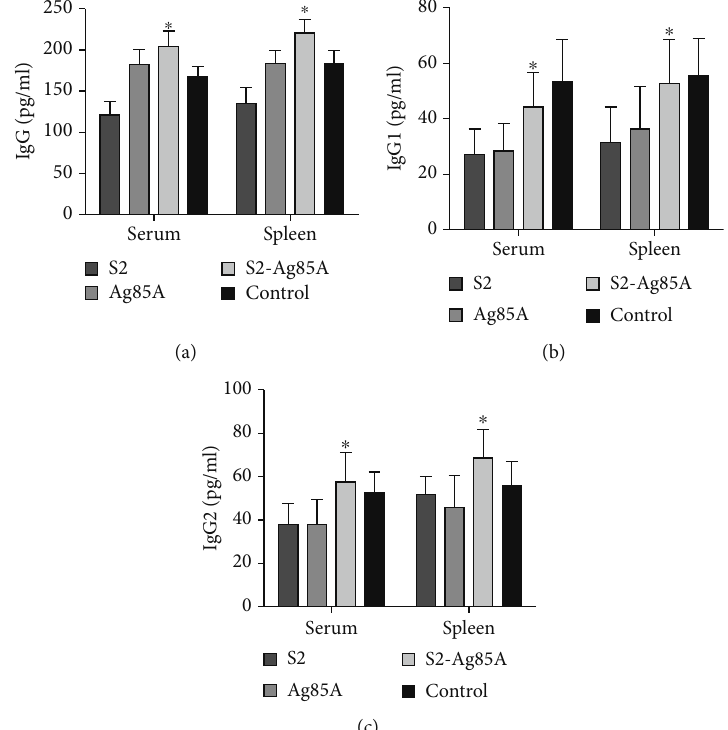
Figure 4: The S2-Ag85A vaccine induces immune responses. (a) In the serum and spleen of mice, the levels of IgG expression are signi fi cantly elevated in the S2-Ag85A group than that in the S2 group ( P value < 0.05). (b) In the serum and spleen of mice, the levels of IgG1 expression are signi fi cantly elevated in the S2-Ag85A group than that in the S2 group ( P value < 0.05). (c) In the serum and spleen of mice, the levels of IgG2a expression are signi fi cantly elevated in the S2-Ag85A group than that in the S2 group ( P value < 0.05). ∗ P < 0 : 05 compared with the S2